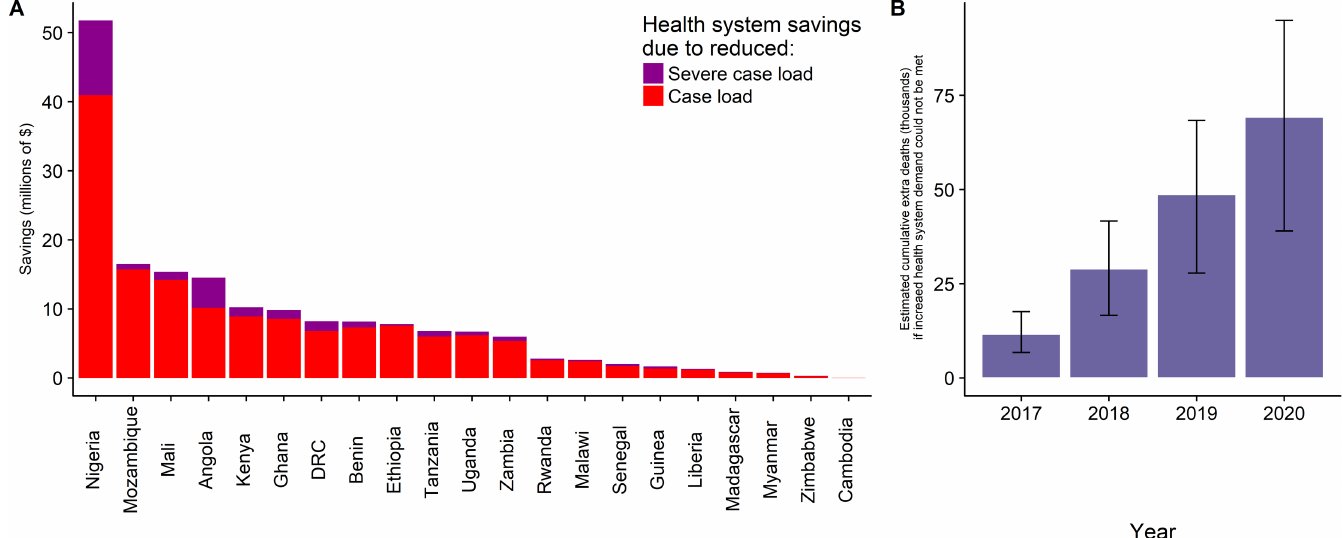
Fig 4. The health-systembenefits associatedwith PMI funding. PMI investment in malaria interventionsreduces caseloadsof nationalhealth systems with resulting (A) averted spendingdue to reducedtreatments of clinicaland severe cases by country. Without PMI investment, these health system gains are lost, potentially resultingin (B) the estimated cumulativemalaria-related deaths in additionto those caused directly by removalof interventionsdue to health systems not being able to respondto increasedcaseloads.PMI, President’sMalariaInitiative.